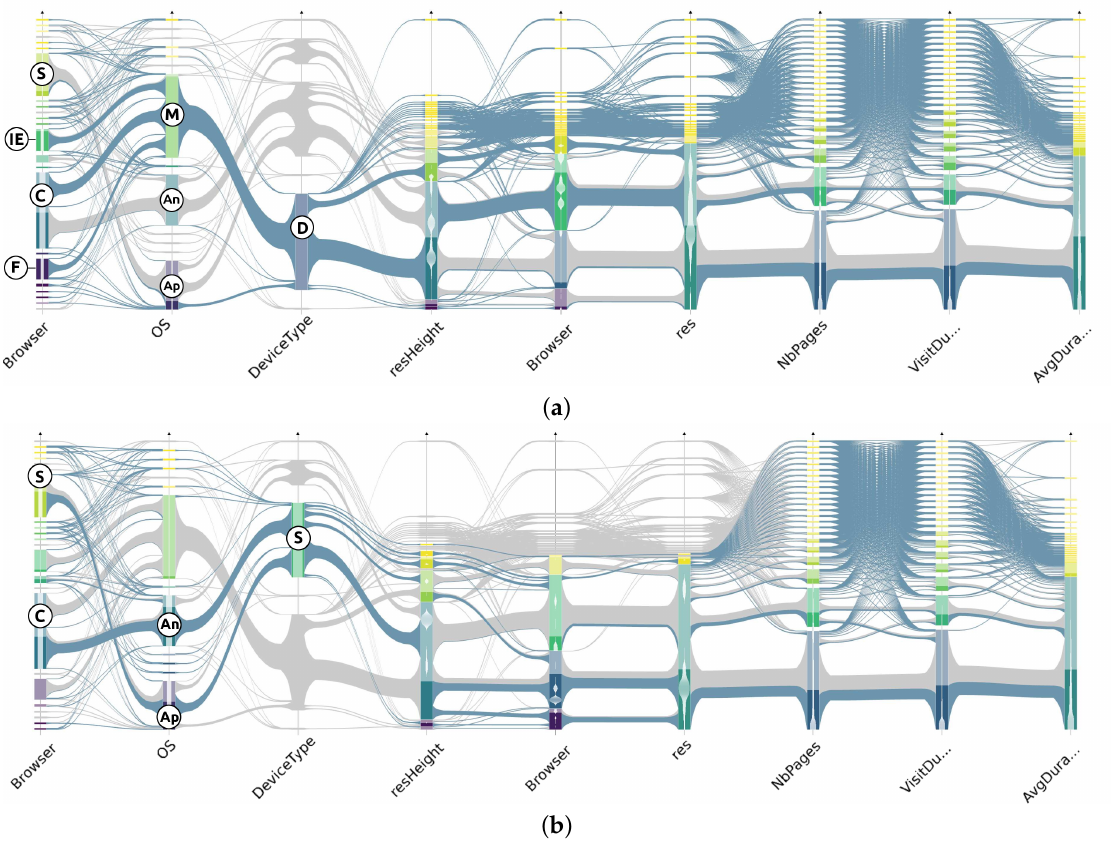
Figure 10. Subset selection: selecting an aggregate highlights the subset over all the plot. ( a ) Selection of desktop devices (D) highlights users using mainly Microsoft (M) operating system and Chrome (C), Internet Explorer (IE) and Firefox (F) browsers; ( b ) Selection of smartphone devices (S) highlights users using almost equally Android and Apple operating systems and the dedicated browsers (resp. Chrome (C) and Safari